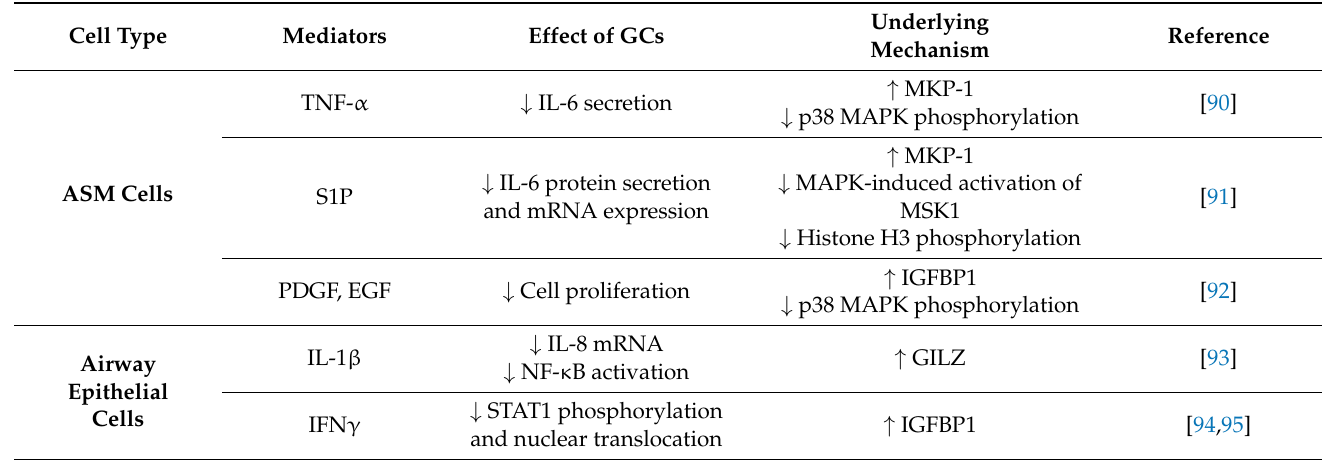
Table 1. Examples of GC effects mediated by transactivation mechanisms in airway structural